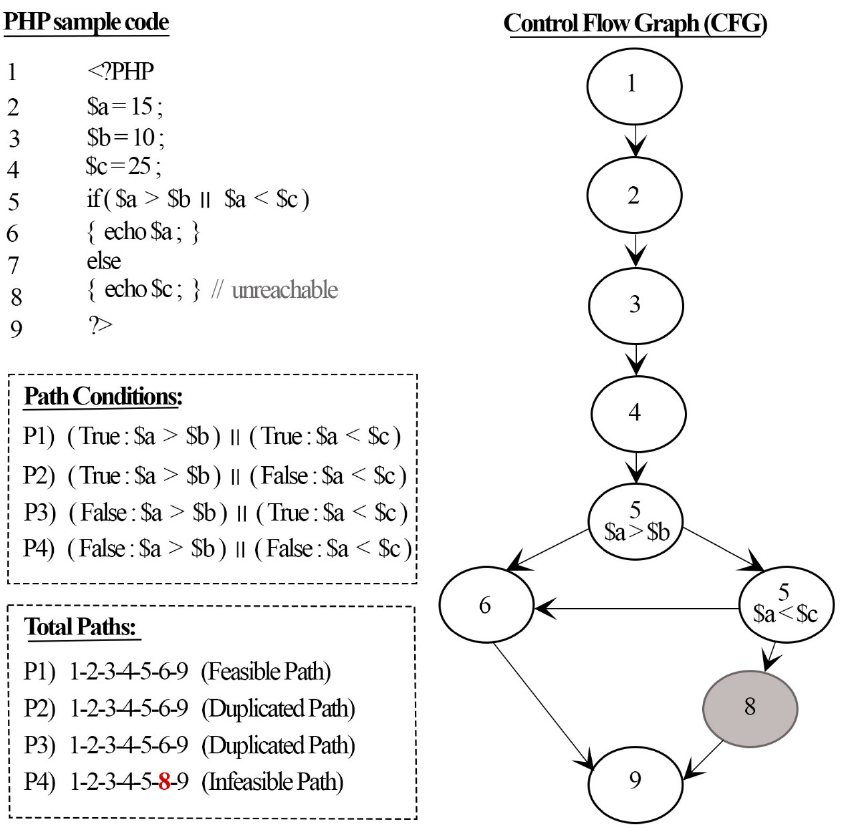
Figure 1. Example of infeasible path and duplicated paths in PHP source